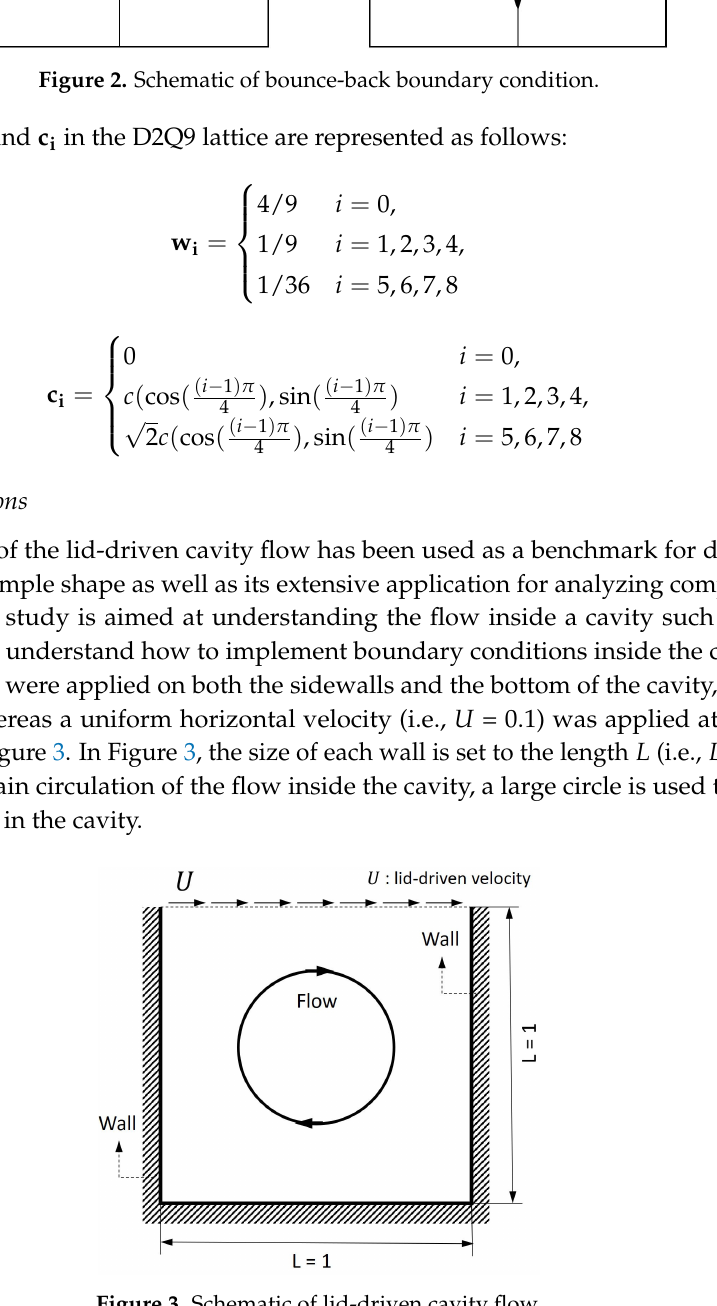
Figure 3. Schematic of lid-driven cavity